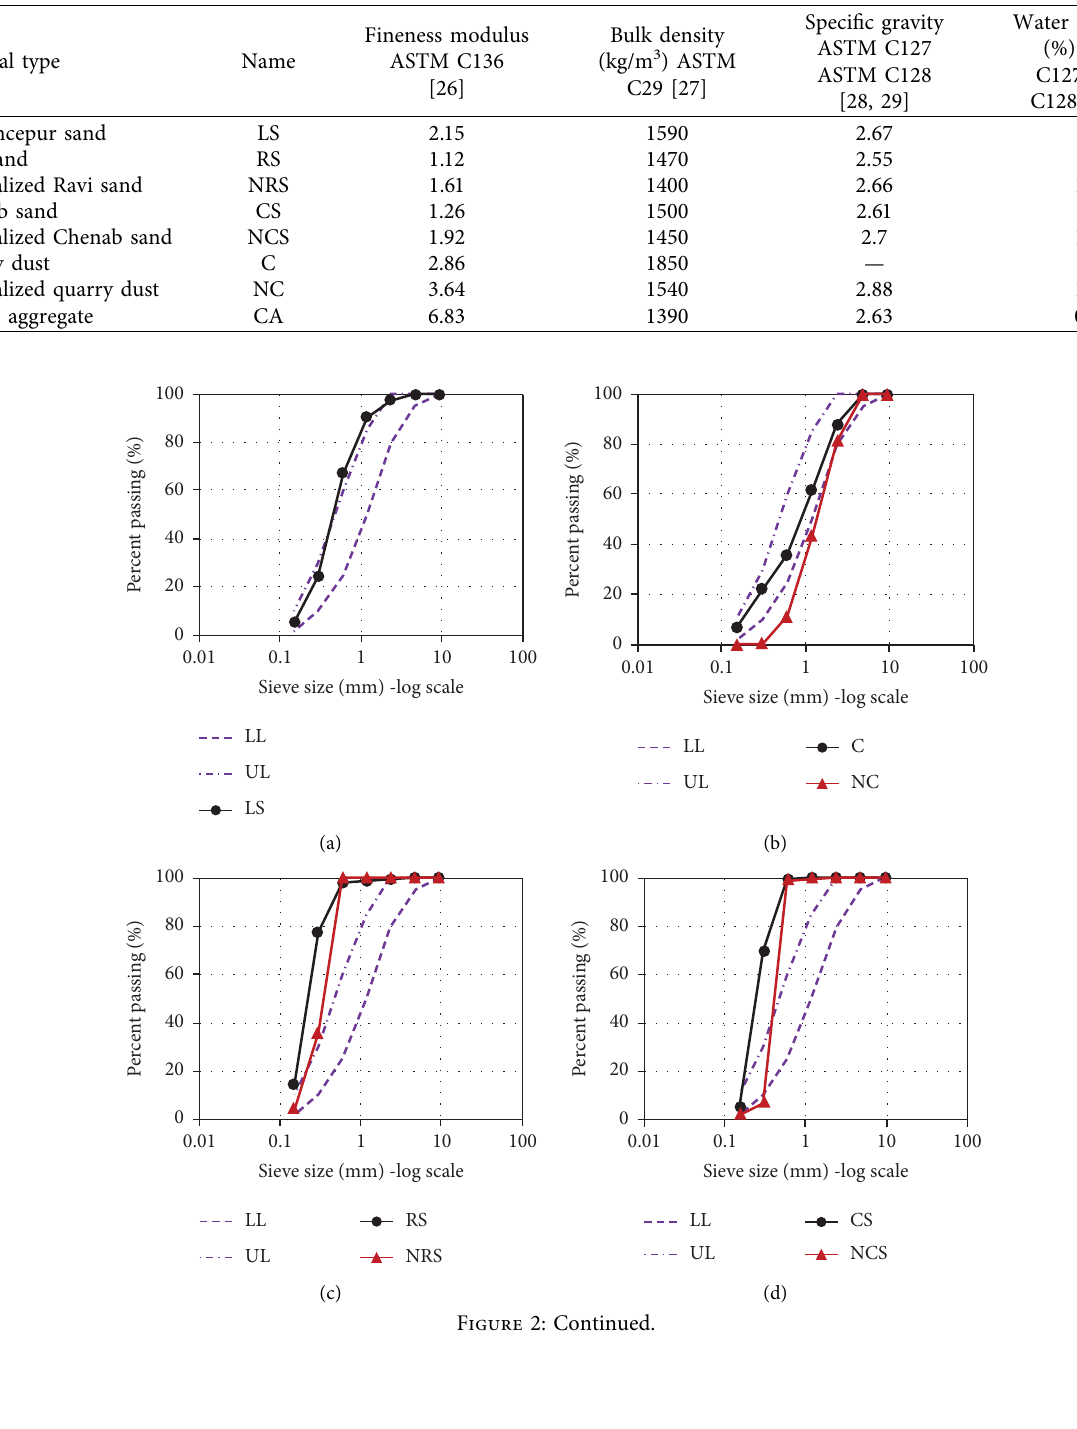
Table 3: Physical properties of fne and coarse